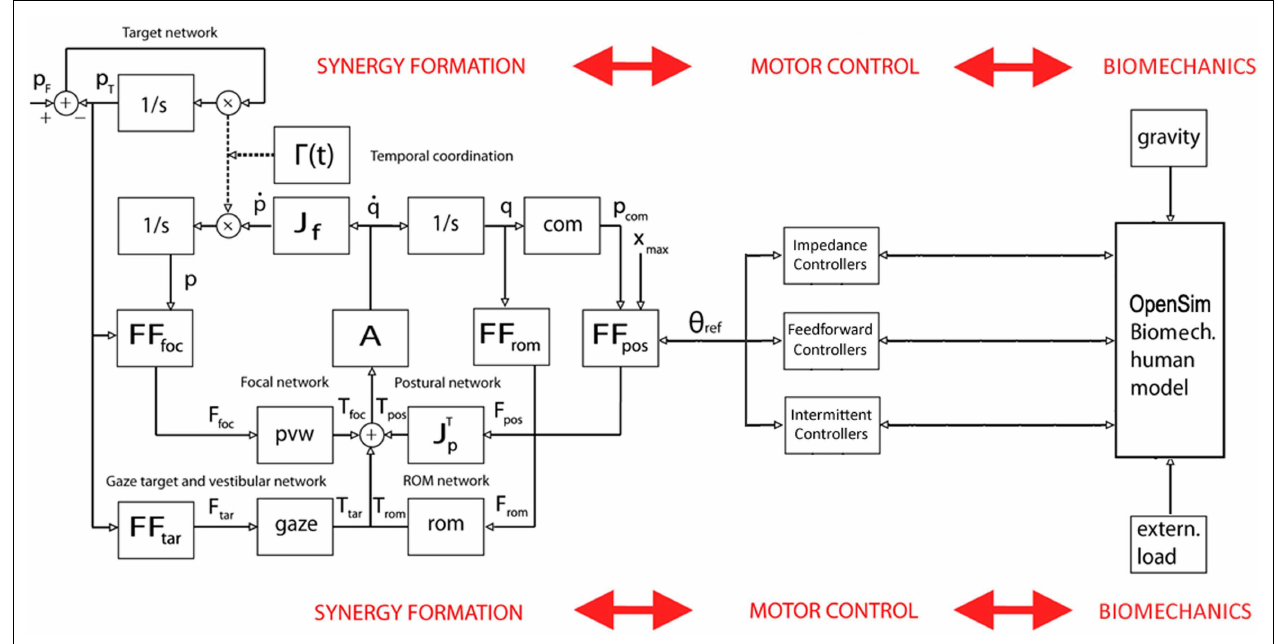
which interact with the OpenSim biomechanical model. In general, the interactions are bidirectional in order to allow adaptation to unpredicted environmental conditions or changing task